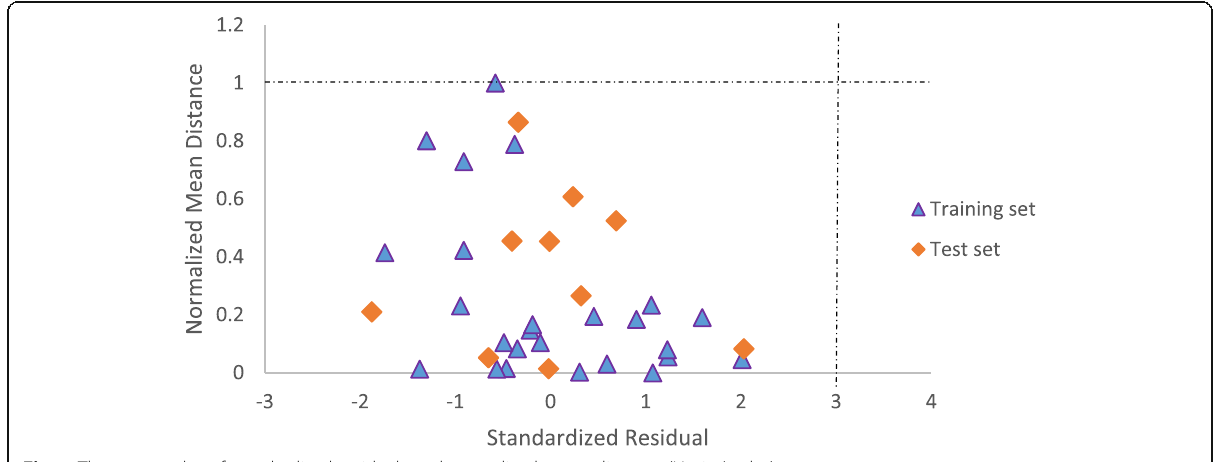
Fig. 4 The scatter plot of standardized residuals and normalized mean distance (Uzairu ’ s plot)